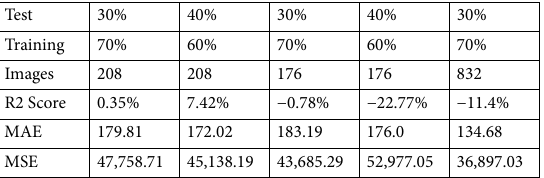
Table 4. Parameters changed to evaluate the accuracy of the CNN model—3T3 cell line.